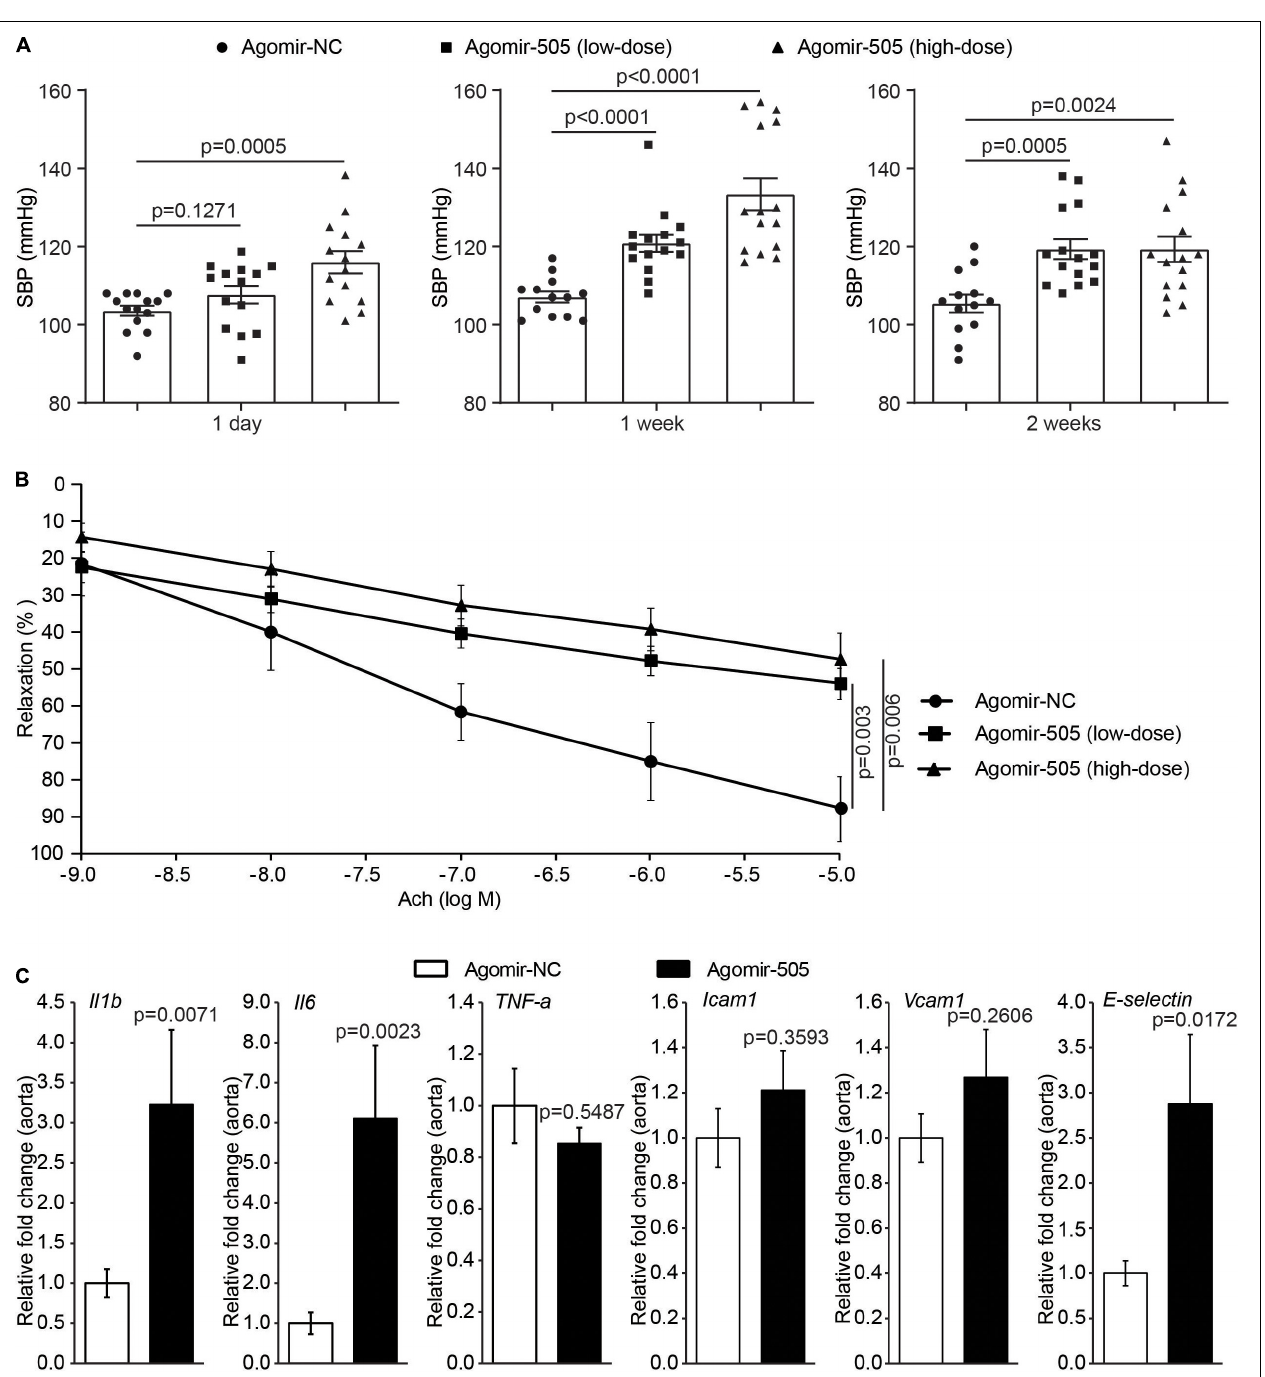
FIGURE 2 | Elevated circulating miR-505 leads to raised blood pressure, impaired endothelium-dependent vasodilation and vascular inflammation. (A) C57/BL6 mice were treated with agomir-NC (10 mg/kg bw, n = 13) or agomir-505 (low-dose: 2.5 mg/kg bw, n = 15; high-dose: 10 mg/kg bw, n = 15) for 2 weeks through intravenous injection. SBP was measured 1 day, 1 week and 2 weeks after the termination of agomir-505 or agomir-NC administration. Data represent mean ± SEM. P values are derived from one-way ANOVA and the Student’s t -test. (B) Two weeks after the termination of agomir-505 or agomir-NC treatment, aortas were dissected and subject to the assessment of endothelium-dependent vasorelaxation to Ach. Data represent mean ± SEM. P values are derived from one-way ANOVA and the Student’s t -test. (C) Agomir-505 (10 mg/kg bw) or agomir-NC (10 mg/kg bw) was intravenously administered for 2 weeks. One week after the last injection, the aortas were dissected, followed by real-time quantitative polymerase chain reaction (qPCR) analyses to examine the expression of Il1b, Il6, TNF-a, Icam1, Vcam1 and E-selectin in agomir-505-treated ( n = 4) or agomir-NC-treated mice ( n = 7). Relative fold change of the expression of the indicated genes was plotted against that from agomir-NC-treated mice. Data represent mean ± SEM. P values are derived from the Student’s t -test.